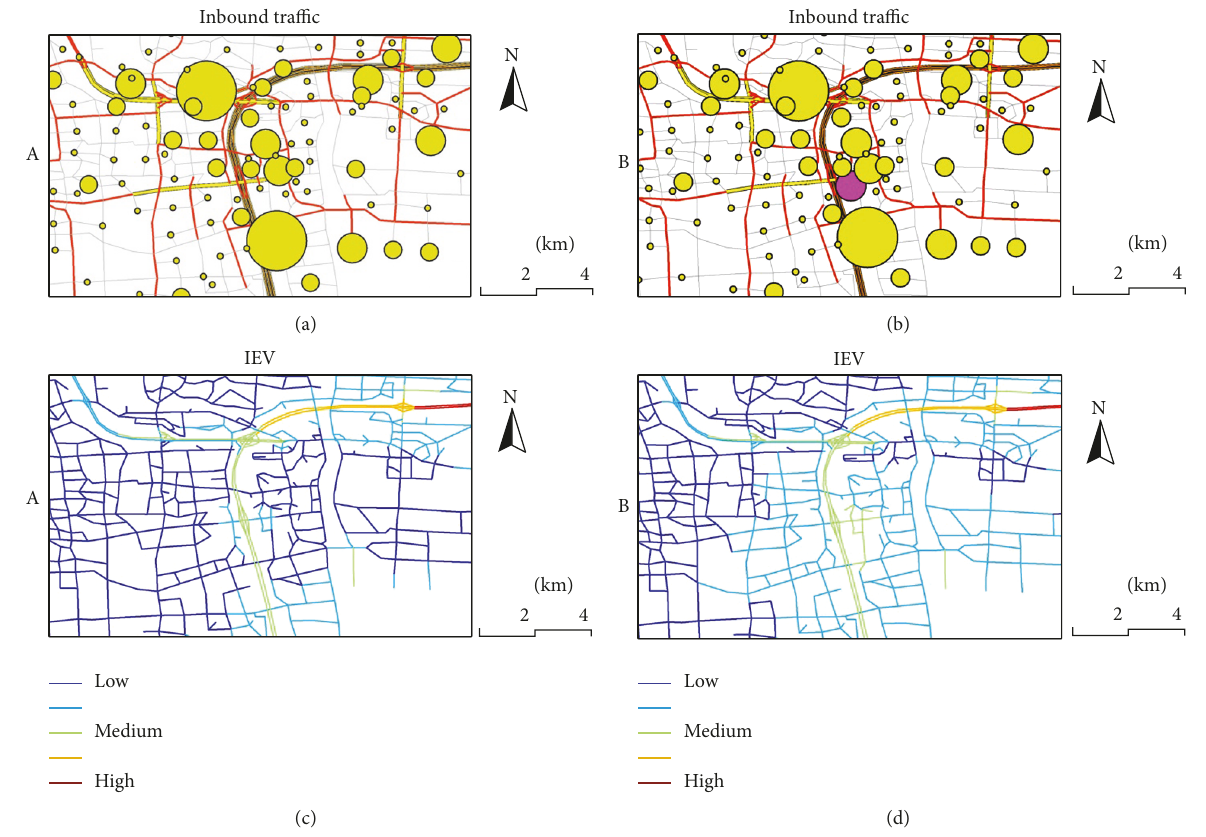
Figure 6: The IEV faced by first responders in two scenarios: (a) original Scenario A; (b) Scenario B with an increased inbound traffic at the mall; (c) IEV of Scenario A; (d) IEV of Scenario